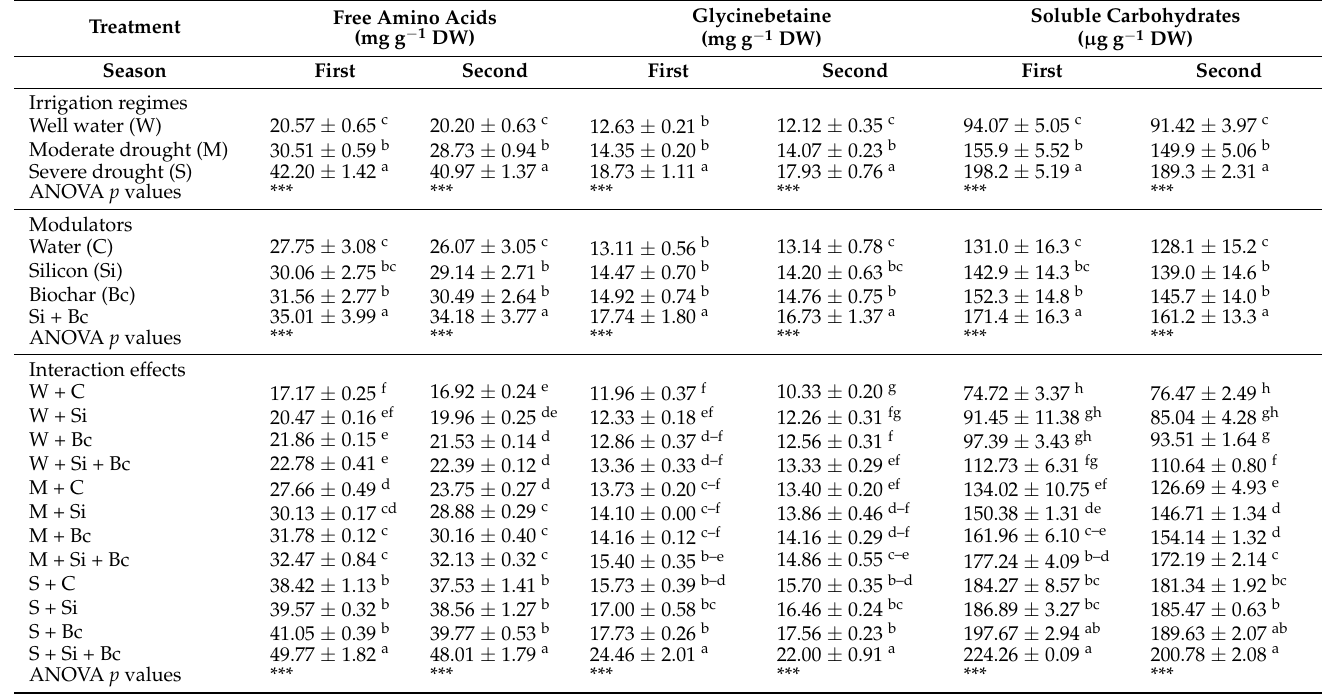
Table 4. Effect of irrigation regimes, silicon, biochar and their interaction on some organic solute concentrations of borage plants throughout two experimental